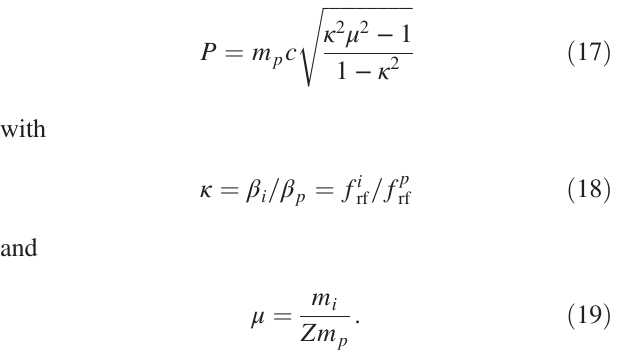
column). The second column from the left corresponds to the rf frequency difference Δ f between a proton and a Pb 82 þ rf